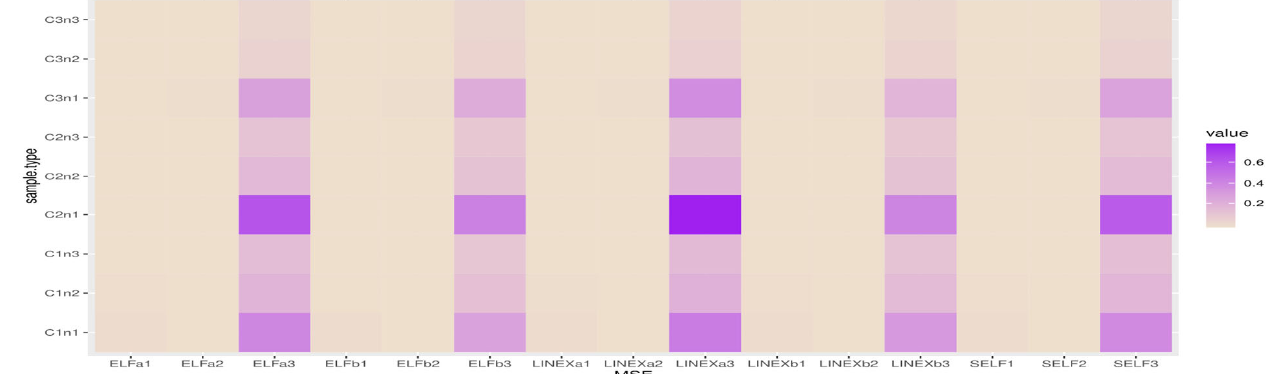
Figure 5. Heatmap for MSE when a = 0.5, b = 1.7.